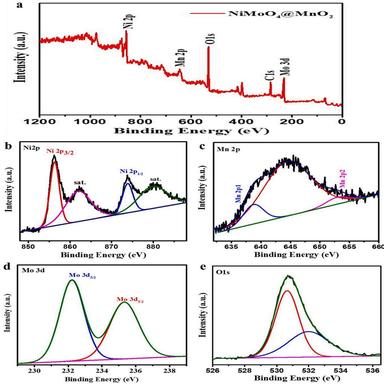
Core level spectra of NiMoO4@MnO2, XPS survey (a), XPS scan and fitting peaks of Ni 2p, (b) Mn 2p (c), Mo 3d (d), and O 1s (e).